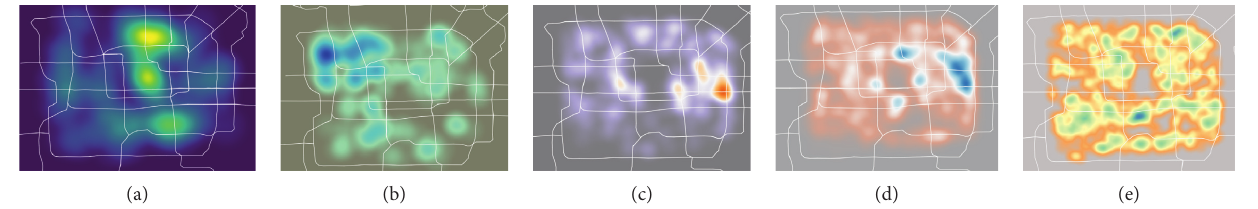
Figure 4: Results of POI data clustering. The color represents the density of POI numbers: (a) park and scenery areas, (b) education area, (c) office area, (d) commercial area, and (e) residential